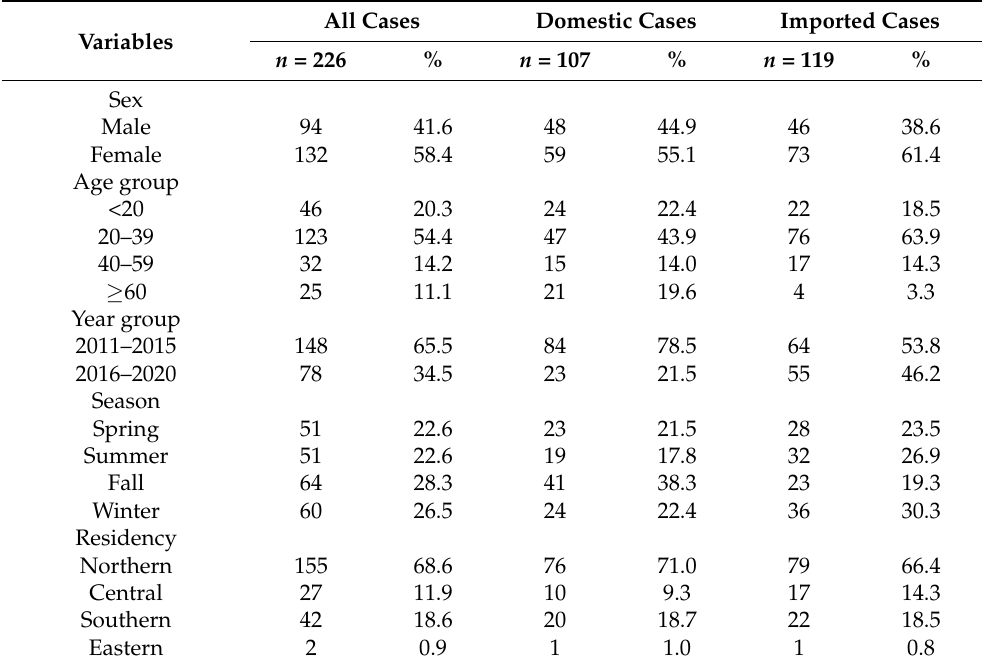
Table 1. Epidemiological features of domestic and imported cases of typhoid in Taiwan during the period